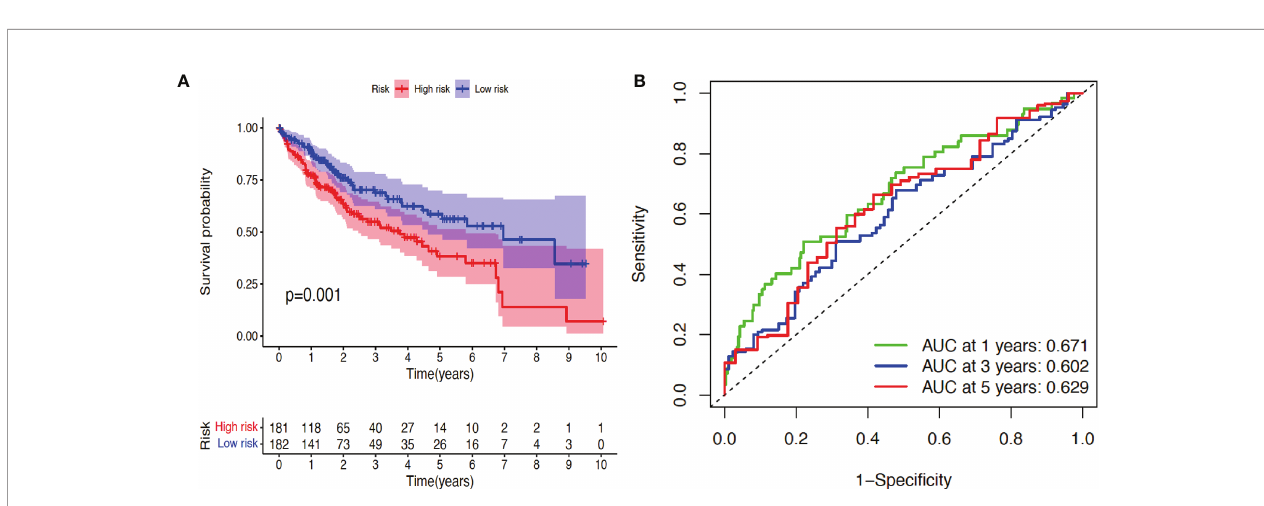
FIGURE 2 | Validation of prognosis model. (A) Kaplan – Meier survival curve analysis of high-risk and low-risk cohorts using package survival. (B) Receiver operating characteristic (ROC) analysis of three different survival times (1, 3, and 5 years) using timeROC and ggplot2 packages. AUC: area under the curve. p < 0.05 indicates statistical signi fi